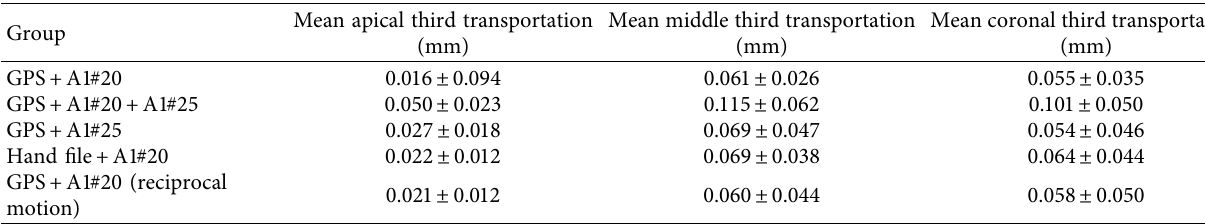
Table 2: Transportation in the lateral view (mm).